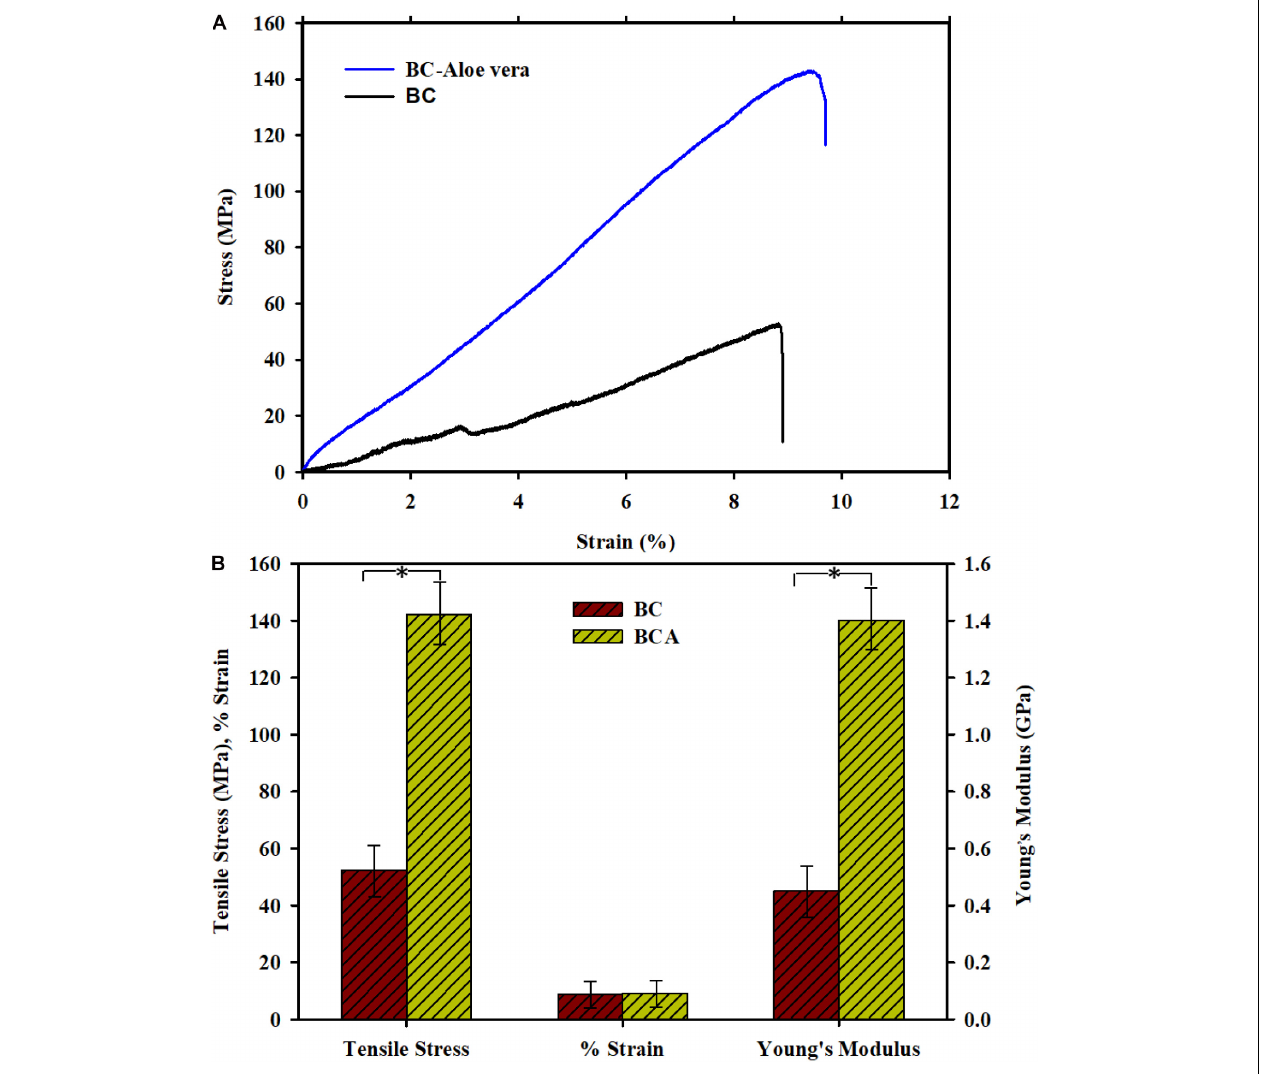
FIGURE 4 | Mechanical properties of pristine BC and ex situ developed Aloe vera -loaded-BC composite (i.e., BCA). (A) Stress-strain curve and (B) Tensile strength, % strain, and Young’s modulus of BC and BCA composite. Asterisk ( ∗ ) indicates a P -value of <